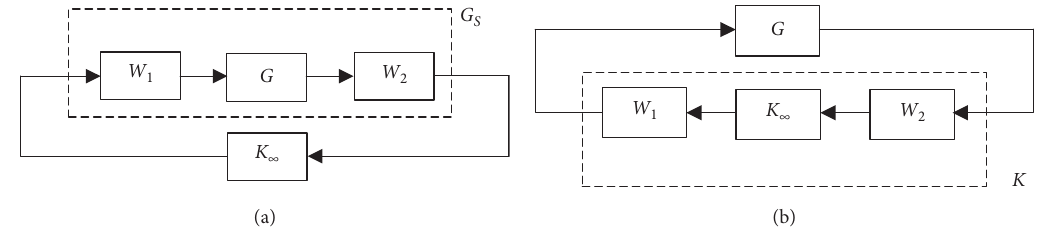
Figure 2: Basic system structure diagram of H